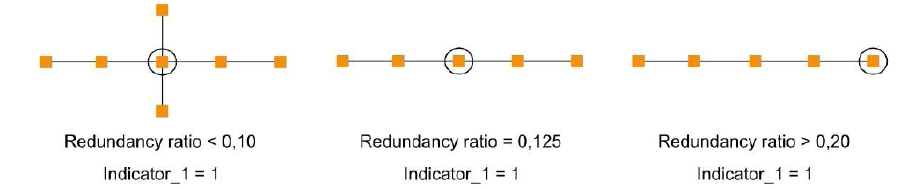
Fig. 4. Correction of some